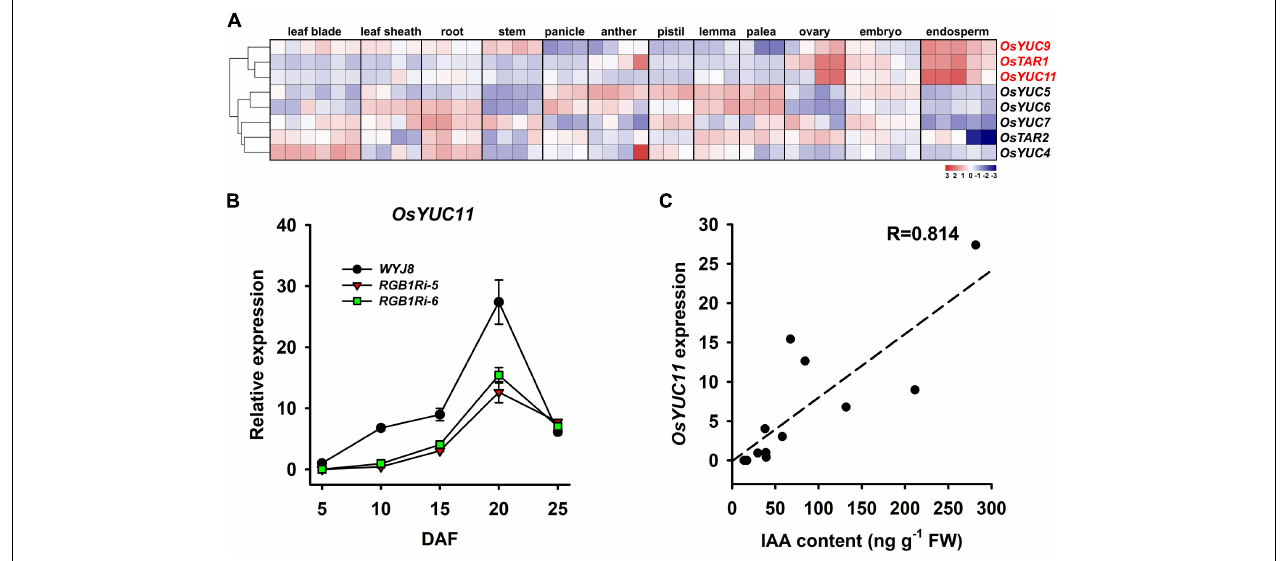
FIGURE 4 | Tissue-specific expressions of OsYUC11 and its relation to auxin content of grains . (A) Expression analysis of OsYUC11 in public microarray data. The maps were plotted using the value of normalized signal intensity for each gene in the different samples: blue indicates low values; red indicates high values. The indicated scale is the log2 value of the normalized level of gene expression. (B) qRT-PCR analysis showing the expression of OsYUC11 in the grains of WYJ8 and RGB1Ri lines during filling stage. (C) The relationship between the expressional levels of OsYUC11 and IAA content in grains.